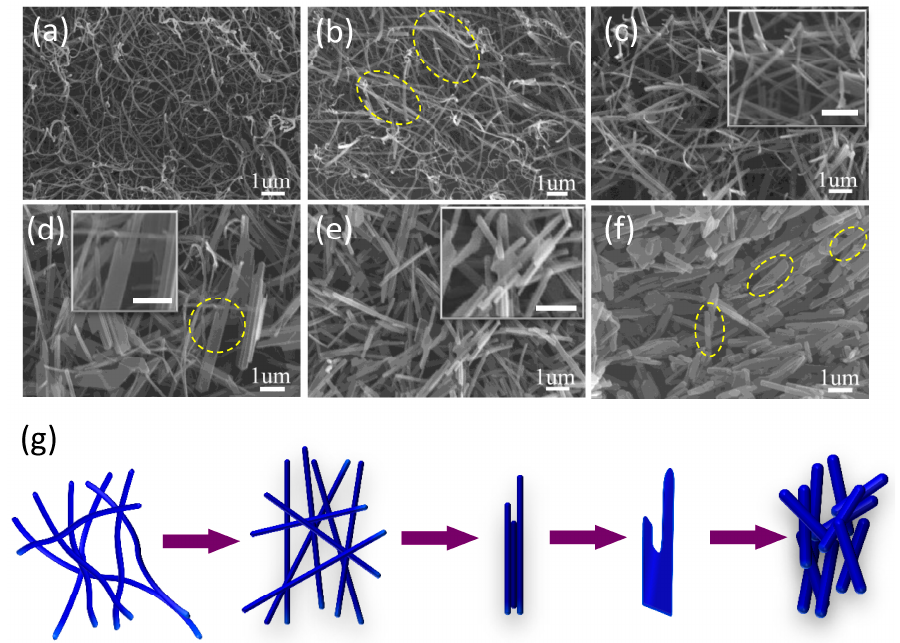
Figure 5. SEM images of CuPc nanowires annealed at different temperatures: ( a ) without annealing, ( b ) 240 °C, ( c ) 270 °C, ( d ) 290 °C, ( e ) 300 °C, and ( f ) 350 °C (scale bar = 1 μ m). ( g ) Schematic of the morphology transition process.